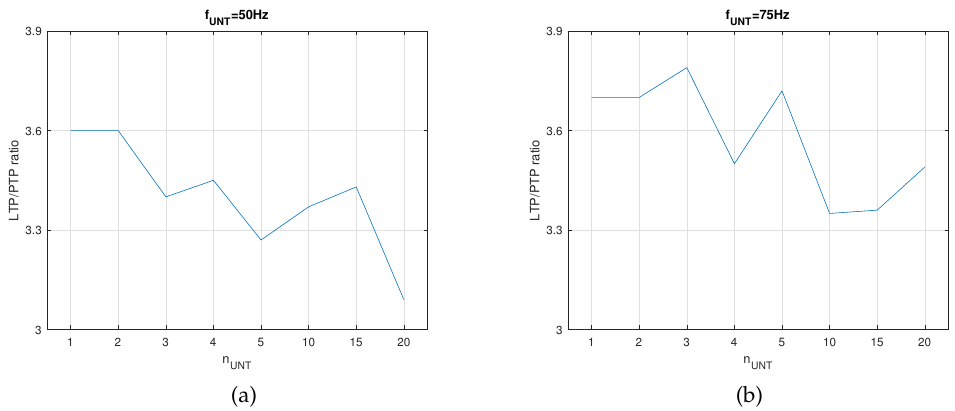
Figure 6. The ratio of potentiation levels between LTP and PTP when the SNN was trained until first activation of post for ( a ) f UNT = 50 Hz and ( b ) f UNT = 75